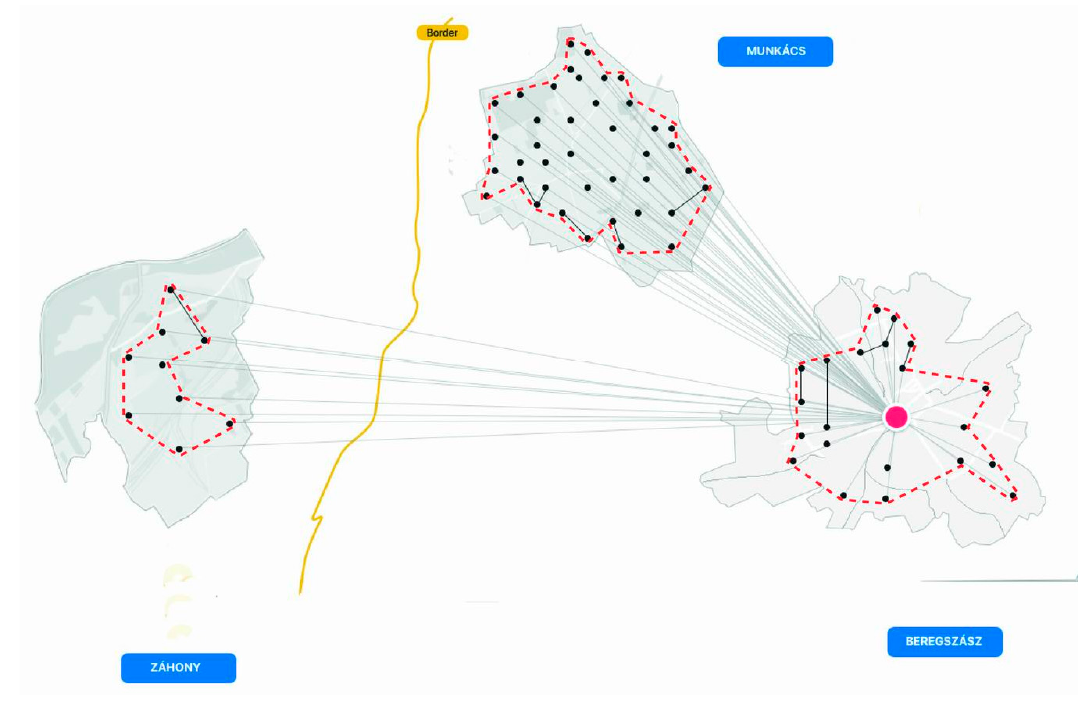
Figure 2. Delimitation of NZBM. Source: Author.